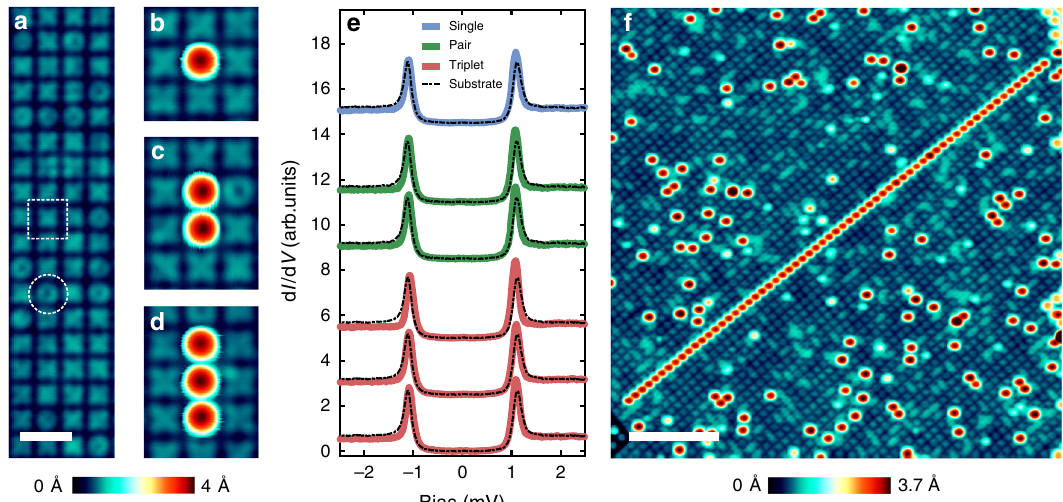
Fig. 1 Spectroscopy of short chains of Fe adatoms. a Constant-current STM image of the typical surface of Ta (100)-O showing a regular array of cross- shaped (dashed rectangle) and circular shaped (dashed circle) plaquettes. White scale bar is 2 nm. b – d STM images showing a single Fe adatom, a pair, and a three-atom chain that were assembled using atom manipulation. e d I /d V spectra measured with a superconducting tip on top of the different chains of Fe adatoms shown in b – d . Each spectrum is plotted together with the spectrum of the substrate taken with the same tip apex. Spectra are shifted vertically and grouped for clarity (STS parameters: V stab = 2.5 mV, I stab = 100 pA, V mod = 20 μ V, scan parameters: V = 50 mV, I = 100 pA). f STM image of a long chain made of 63 Fe adatoms. White scale bar is 10 nm long ( V = 100 mV, I = 100